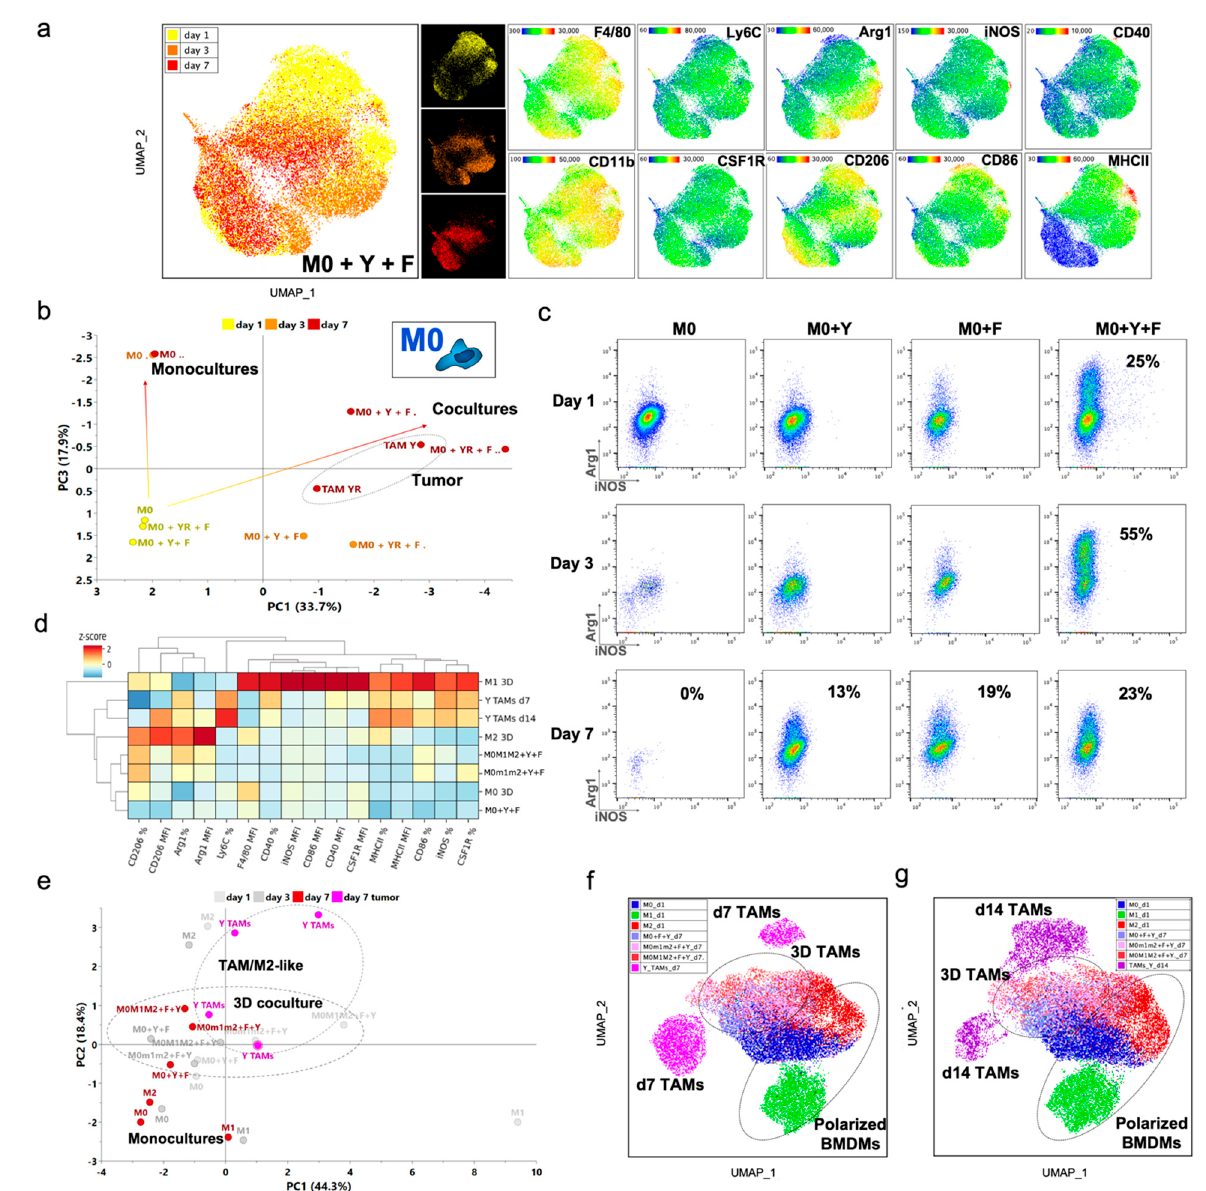
Figure 5. Evolution and modeling of BMDM phenotype into a TAM-like state. ( a ) Analysis of unstimulated BMDM (M0) phenotype over time in 3D co-cultures. UMAP clustering showing macrophages from the M0+F+Y co-culture at d1, d3 and d7 combined. Heatmaps provide detailed distribution of marker expression, highlighting different subpopulations and evolution over time. ( b ) PCA analysis of M0 BMDM phenotype trajectory over time in 3D cultures, compared to day 7 melanoma TAMs. ( c ) Representative dot plots of M1/M2 markers iNOS/Arg1 in M0 BMDMs as mono-cultures and different combinations of macrophage 3D co-cultures, and their evolution over time. ( d ) Hierarchical clustering of marker z-score of macrophages from polarized BMDM profiles, 3D co-cultures at d7 and early (d7) and late (d14) melanoma tumors. ( e ) PCA analysis of macrophage phenotype over time in 3D co-cultures. Highlighted in color, M0 3D mono-cultures and co-cultures and TAMs, collected on day 7. Dashed circles delineate the phenotypic space by sample type, showing the partial overlap between the YUMM TAMs and in vitro “3D TAMs”. ( f ) UMAP clustering of macrophages from 3D mono- and co-cultures and early (d7) melanoma tumors, comparing single-cell phenotype. ( g ) UMAP clustering of macrophages from 3D mono- and co-cultures and late (d14) melanoma tumors, comparing single-cell phenotype. In M0M1M2, polarized BMDMs were mixed in equal parts in the same culture. In (1) M0M1M2, polarized BMDMs were mixed in equal parts in the same culture. In (2) M0m1m2, polarized BMDMs were mixed in ratio 4:1:1 in the same culture. In (3) M0+Y+F. Interestingly, when BMDMs were pre-polarized with an M1 or M2 phenotype, they exhibited different trajectories in their temporal phenotypic evolution in the co-cultures that were distinct from the mono-cultures, but were also less similar to the TAMs than